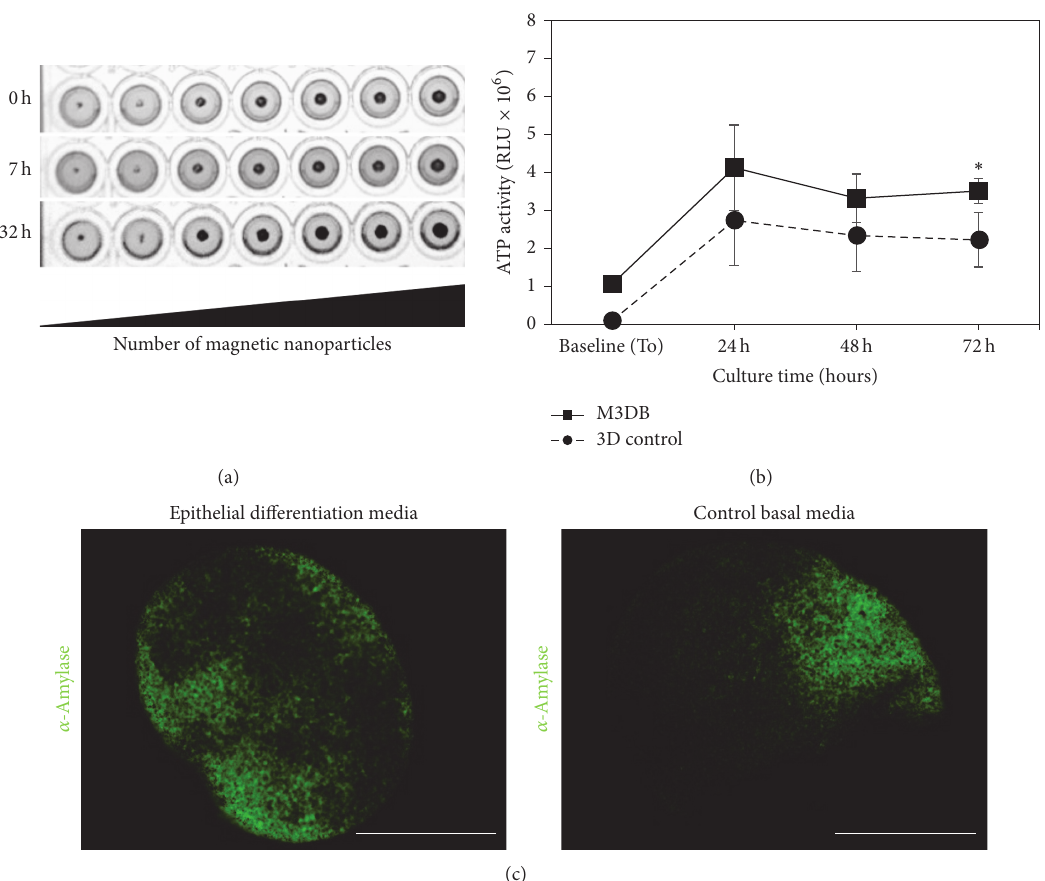
Figure 2: Morphology and viability of the M3DB spheroid-like organoids after 3D bioprinting of human dental pulp stem cell (hDPSC) cultures in a 96-well plate. (a) Morphology of the M3DB spheroids after 7 h and 32 h of culture of 3 × 10 5 hDPSC using increased concentration of magnetic nanoparticles for cellular tagging and magnetization. (b) ATP activity of M3DB compared to a conventional 3D system (3D control) from baseline to 72 hours after seeding 1 × 10 5 hDPSC at baseline (time 0 h). ATP activity was measured by a luciferase ATP-based 3D assay (CellTiter-Glo 3D Cell Viability Assay, Promega, USA) with a Glomax luminometer (RLU: raw luminescent units); significant difference found between the two culture systems (M3DB and 3D control) at 72 h ( ∗ 𝑝 = 0.0286 ); 𝑁 = 4 - 5 ; Two-tailed t -test. (c) Organoids expressing 𝛼 -amylase salivary protein after epithelial differentiation (GlutaMAX basal media with FGF-10 40 ng, Gibco) of hDPSC for 14 days. Organoids were processed for whole mount immunofluorescence staining with 𝛼 -amylase primary antibody and Alexa Fluor (cid:2) 488 (green) followed by confocal fluorescence microscopy. Images are a maximum intensity projection of a z-stack of images taken through the entire organoid thickness (magnification: 10x; scale bar: 250 𝜇